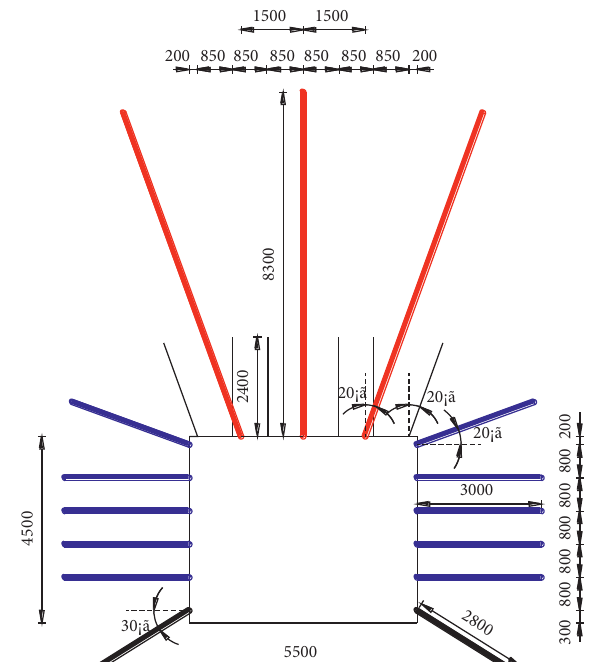
Figure 14: Roadway support section.